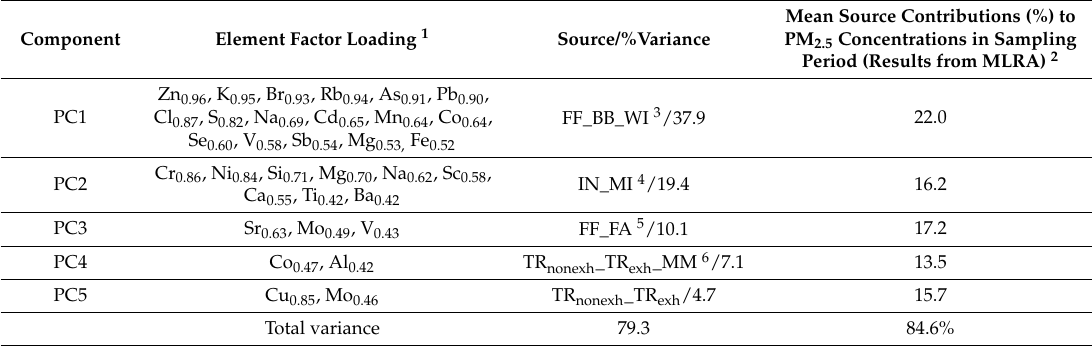
Table 4. Results of the principal component (PCA) and multi-linear regression (MLRA) analyses performed for PM 2.5 and PM 2.5 -bound element